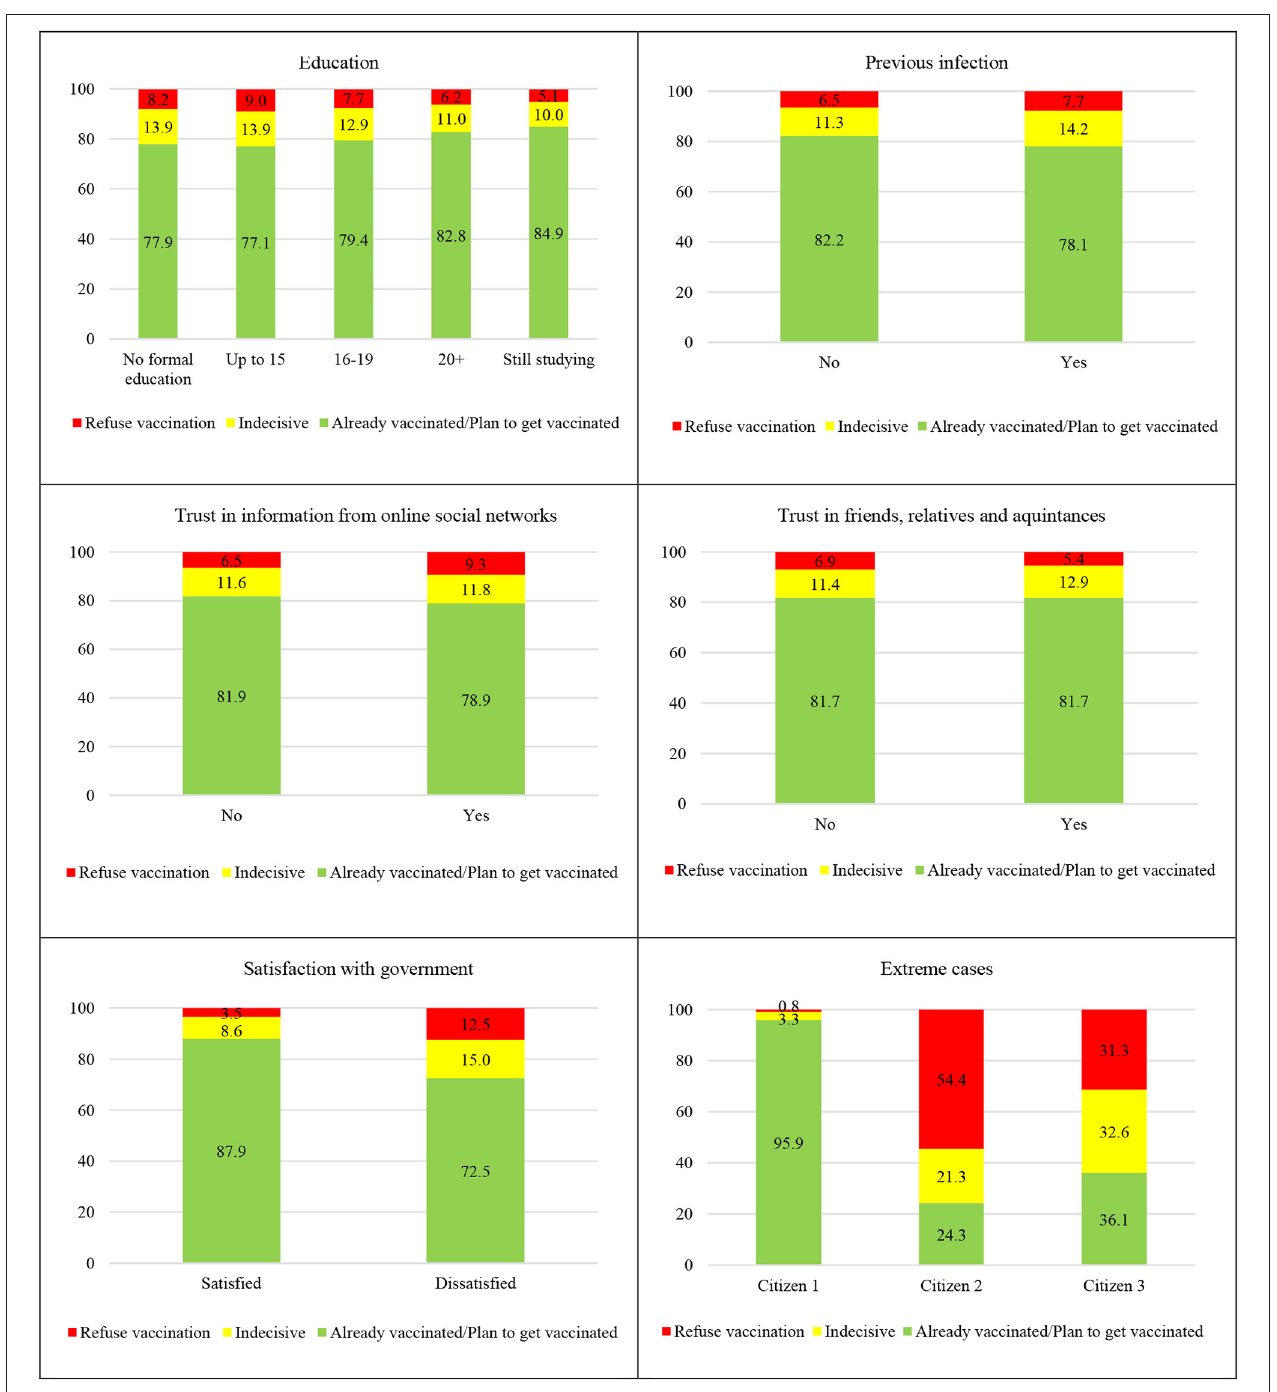
FIGURE 3 | Predicted probabilities by different criteria, %. (1) Panels 1–5 illustrate how the change in the observed variable affects the predicted probabilities for an average EU citizen. (2) Panel 6 shows the predicted probabilities in the extreme scenarios. Citizen 1—was not ill because of COVID-19, but knows people who were seriously ill; satisfied with the way government has handled the vaccination strategy (including the transparency issues); does not rely on friends, relatives, media, or online social networks when seeking information on COVID-19; does not think she/he can avoid infection without vaccination; still studying. Citizen 2 —was ill because of COVID-19, but does not know people who were seriously ill; dissatisfied with the way government has handled the vaccination strategy; relies on media and online social networks when seeking information on COVID-19; thinks she/he can avoid infection without vaccination; finished education by the age of 15. Citizen 3—was ill because of COVID-19, but does not know people who were seriously ill; dissatisfied with the way government has handled the vaccination strategy; relies only on friends and relatives when seeking information on COVID-19; thinks she/he can avoid infection without vaccination; never had formal education. Source: Author’s own calculations based on Flash Eurobarometer